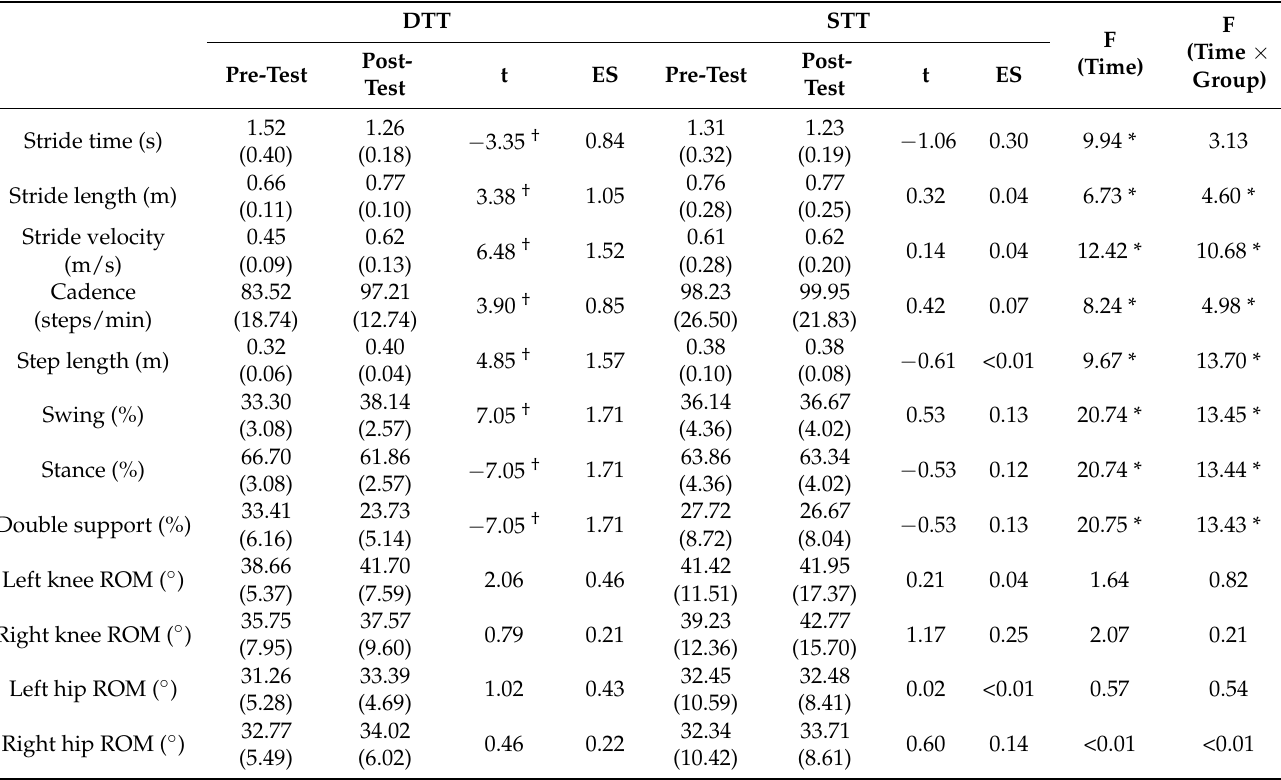
Table 3. The data for the gait parameters before and after training between the